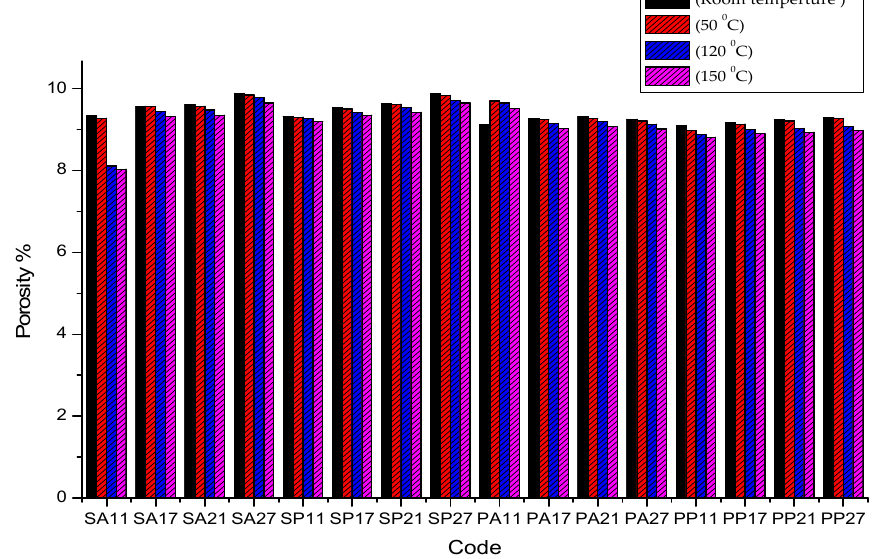
Figure 6. variation of the porosity % with the changing in the heat treatment temperature.